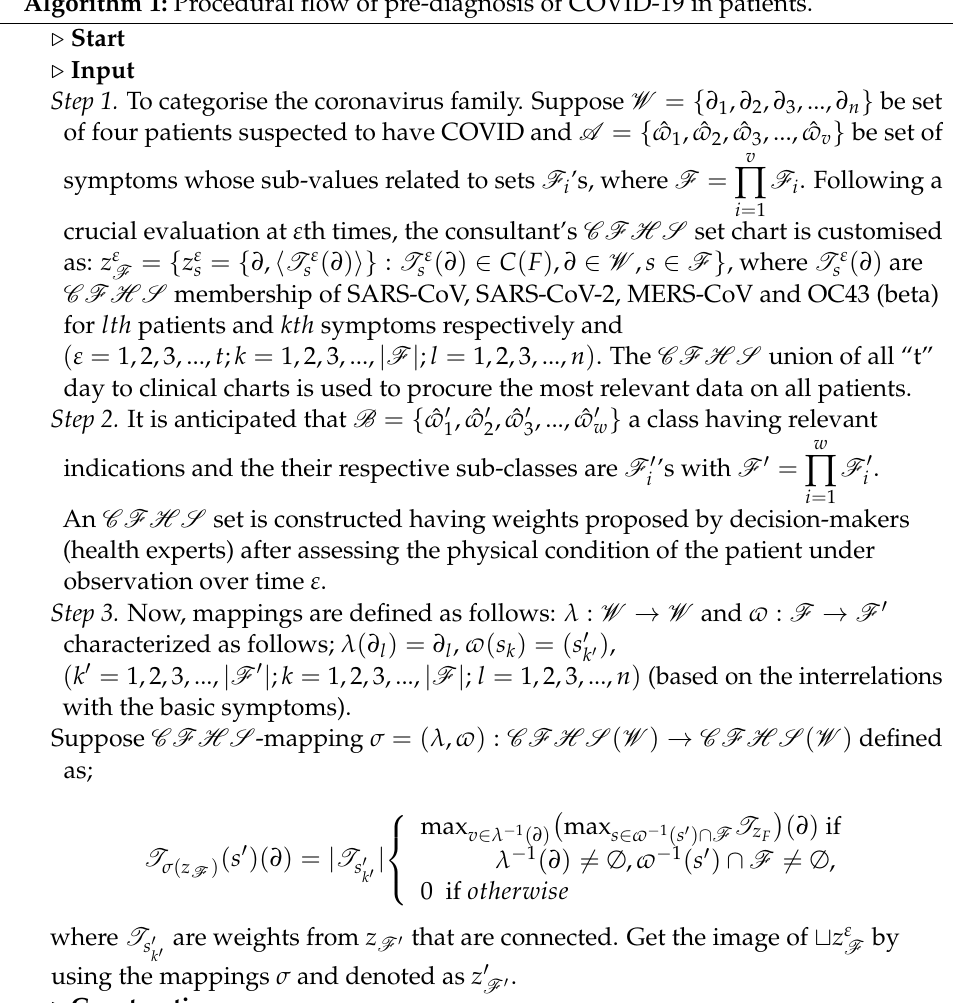
Algorithm 1: Procedural flow of pre-diagnosis of COVID-19 in